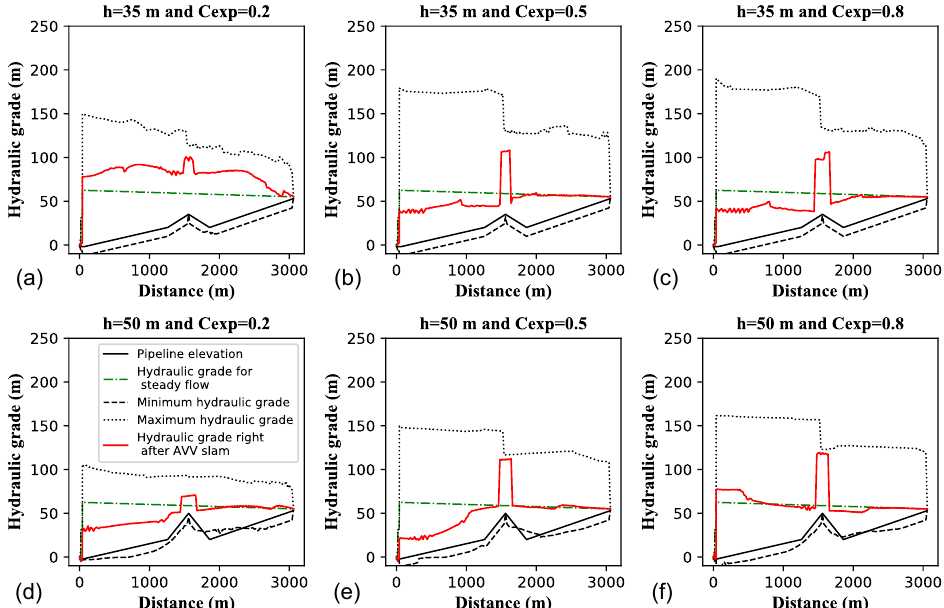
Figure 3. Maximum and minimum hydraulic grade lines and hydraulic grade line right after AVV slam (first air cavity collapse) in a pump trip scenario: ( a – c ) for air valve at elevation of 35 m; ( d – f ) for air valve at elevation of 50